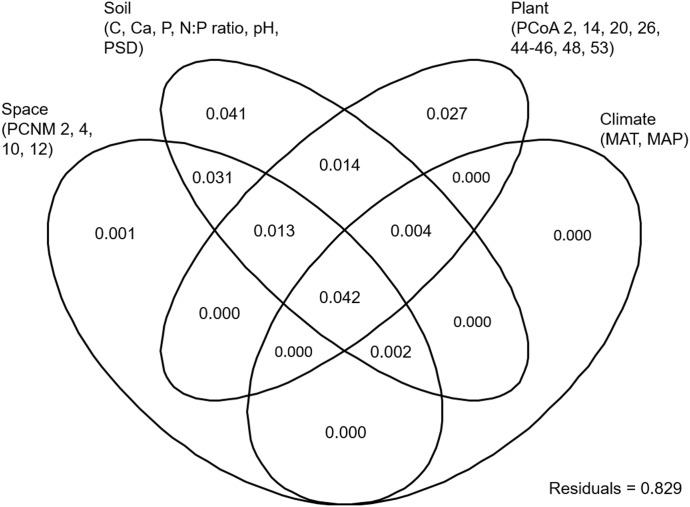
Variation partitioning showing the pure and shared effects of plant, soil, climatic and spatial variables on ectomycorrhizal fungal richness. Numbers indicate the proportions of variation explained. C, total soil carbon; N, total soil nitrogen; P, total soil phosphorus; Ca, total soil calcium; PSD, particle size distribution; PCNM, principal coordinates of neighbor matrices. PCoA, principal coordinates analysis of host phylogeny; MAT, mean annual temperature; MAP, mean annual precipitation.